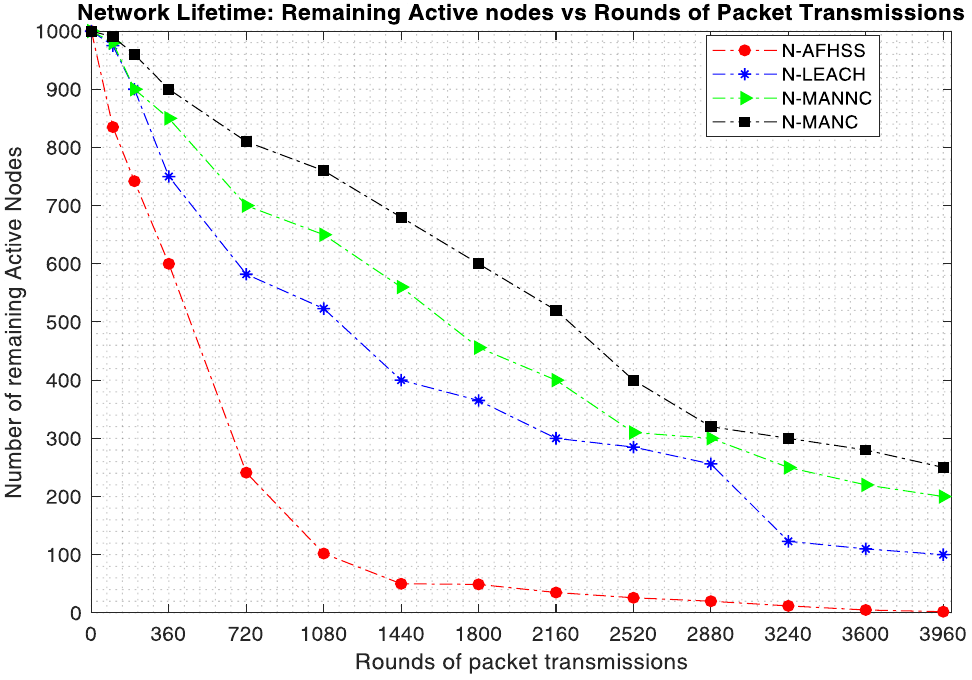
Figure 6. Network lifetime: remaining nodes versus round of transmission